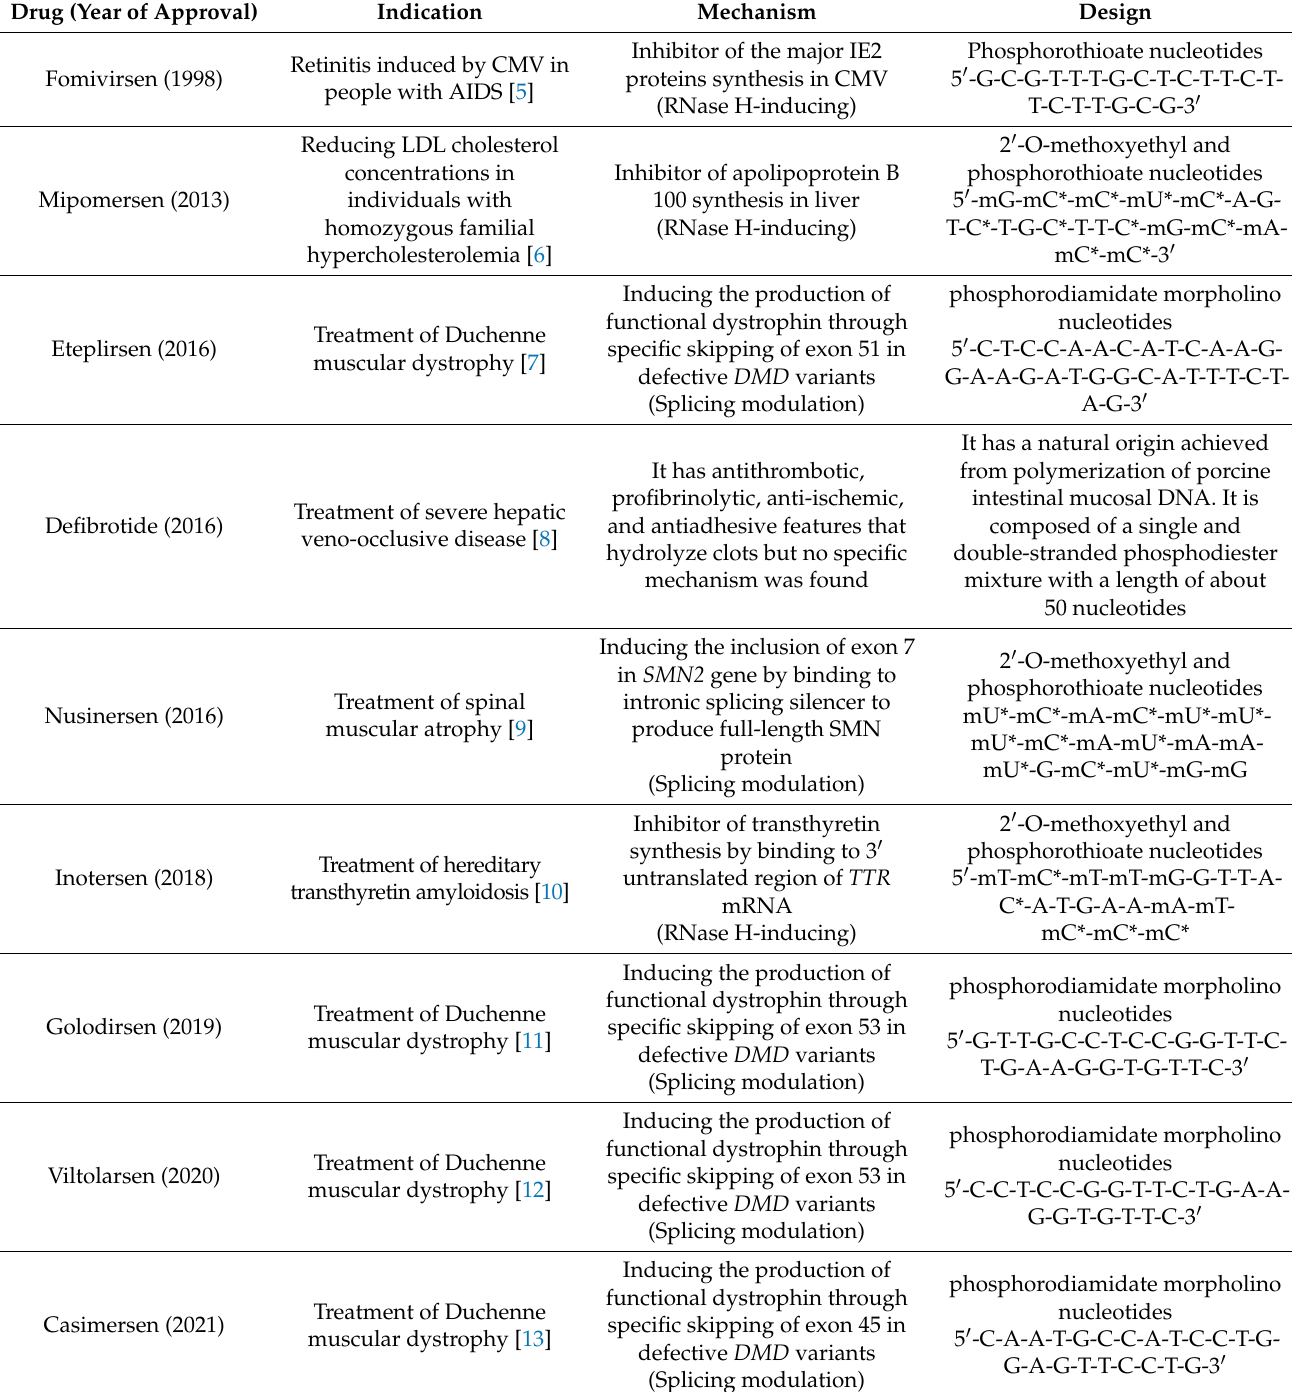
Table 1. FDA-approved antisense